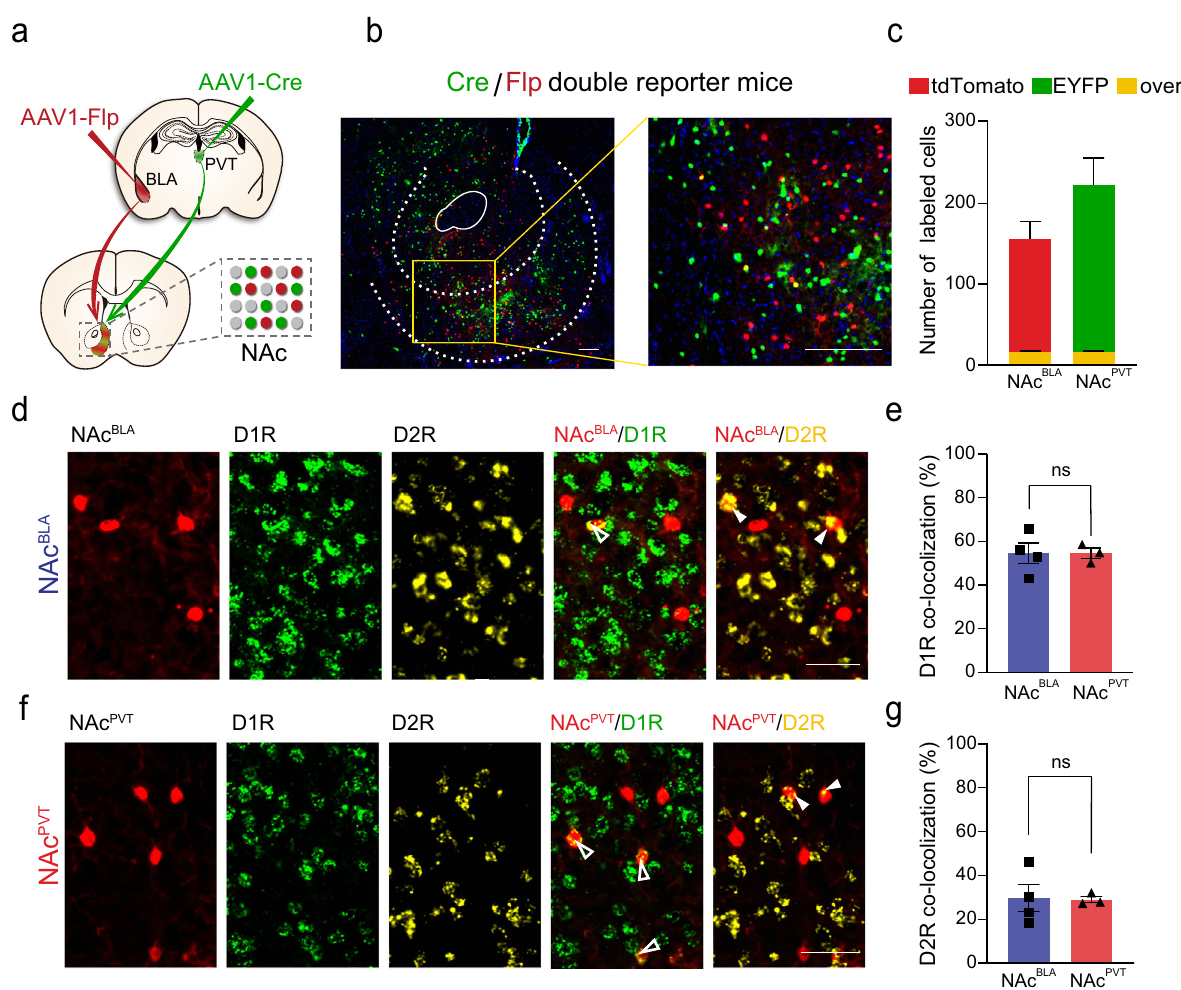
Fig. 1 | Distribution of NAc BLA and NAc PVT neurons in the NAc. a Strategy using AAV1-mediated anterograde transsynaptic tagging to label NAc neurons receiving BLA input (NAc BLA ) and NAc neurons receiving PVT input (NAc PVT ) in Cre/Flp double-reporter mice. b Example image showing labeled NAc BLA (red) andNAc PVT (green)neurons.Scalebar:100 μ m. c Quanti fi cationofthenumberof anterograde labeled NAc BLA and NAc PVT neurons in the NAc in Cre/Flp double- reporter mice ( n =5). Mean±s.e.m. d Example images showing the distribution of NAc BLA neurons (red), D1R-MSNs (green), and D2R-MSNs (yellow) in NAc.